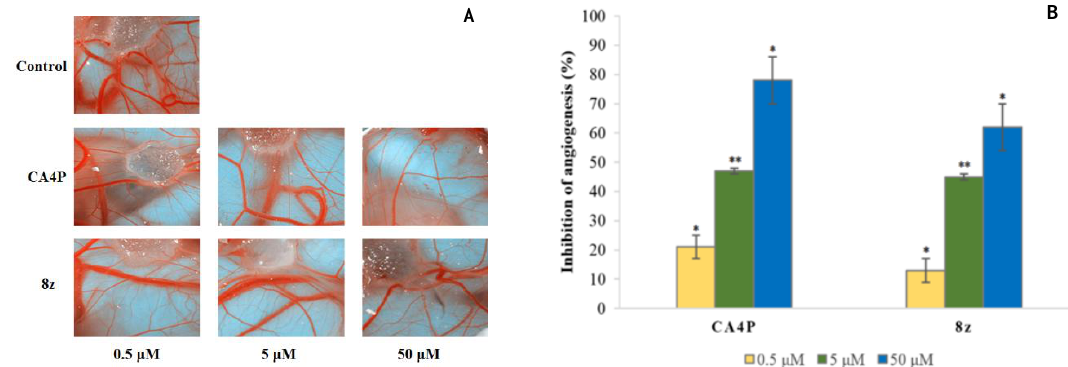
Figure 4. In vivo anti-angiogenic effect of compounds 8z in CAM assay. A . The representative photos of the experiments. B . The anti-angiogenetic activity of compound 8z was semi-quantitatively analyzed using Graph Pad Prism 5.0. The data represent the mean values ± SD of at least three independent determinations. (**, P < 0.05; *, P < 0.5).